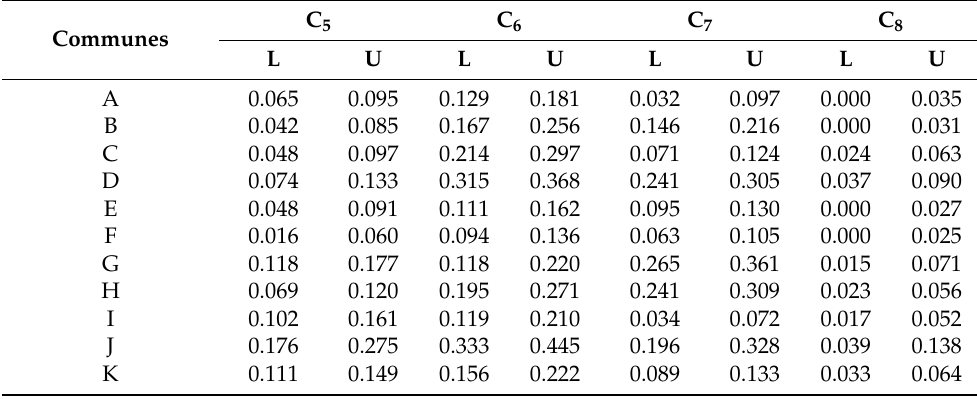
Table 8. Degrees of nonmembership in the form of intervals for criteria C 5 –C 8